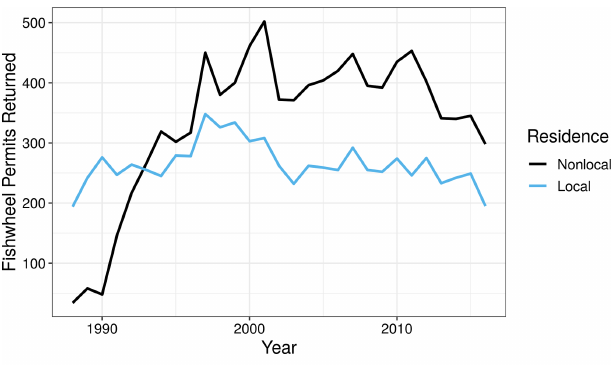
Fig. 6 . Number of fish wheel permits returned by local/ nonlocal residency,